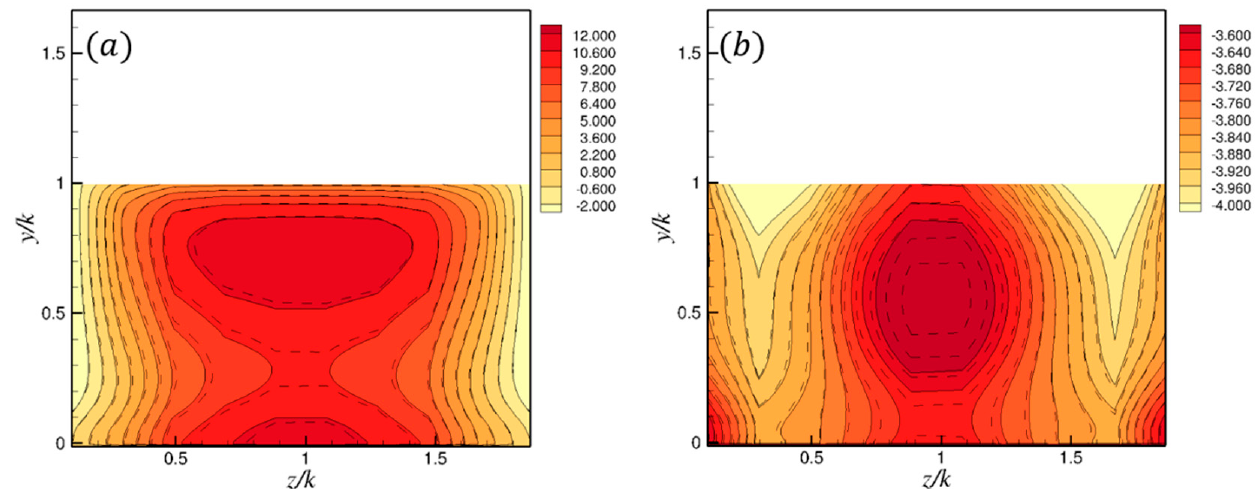
)/𝜌𝑢 (cid:3099)(cid:2870) on the ( a ) windward and ( b ) leeward face of a roughness Figure 7. Distribution of (𝑝 − 𝑝 Figure 7. Distribution of ( p − p 0 ) / ρ u 2 τ on the ( a ) windward and ( b ) leeward face of a roughness (cid:2868) element. Color contour and solid lines: at 𝑥 = 380 𝜃 ; dashed lines: at 𝑥 = 710 𝜃 element. Color contour and solid lines: at x = 380 θ 0 ; dashed lines: at x = 710 θ 0 . Here, p 0 is the (cid:2868) reference pressure. reference